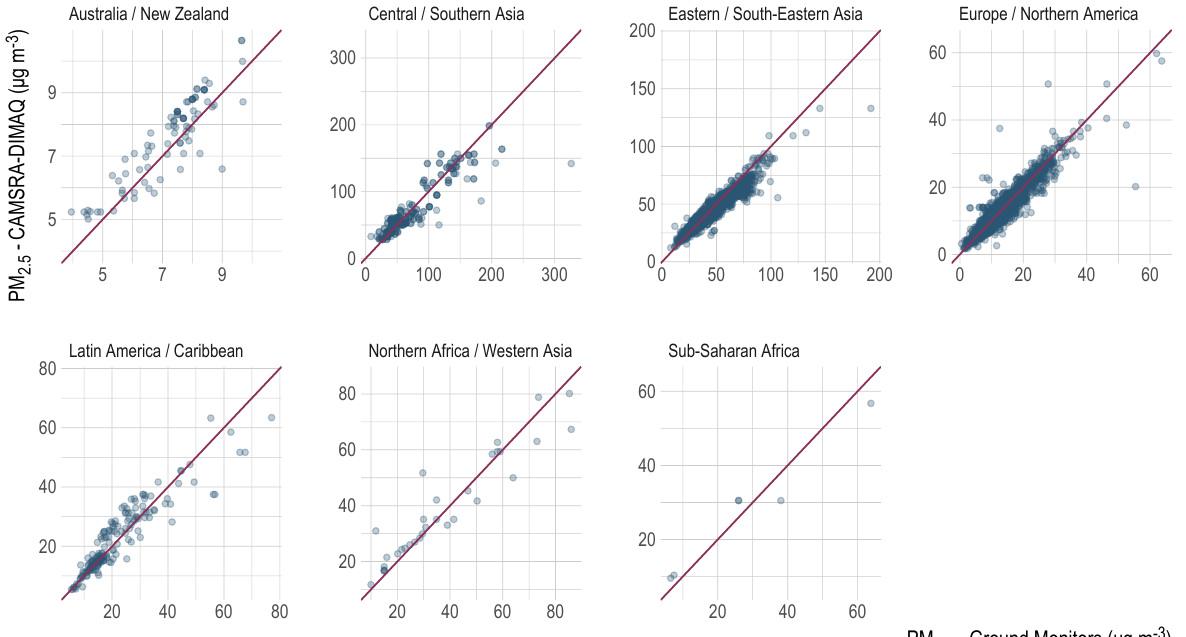
Figure 4. Comparison between the annual average of PM 2.5 estimated by DIMAQ while using the Copernicus Atmosphere Monitoring Service multi-annual global reanalysis of atmospheric composition and ground measurements, by SDG region, for 2016. Red lines indicate a one-to-one